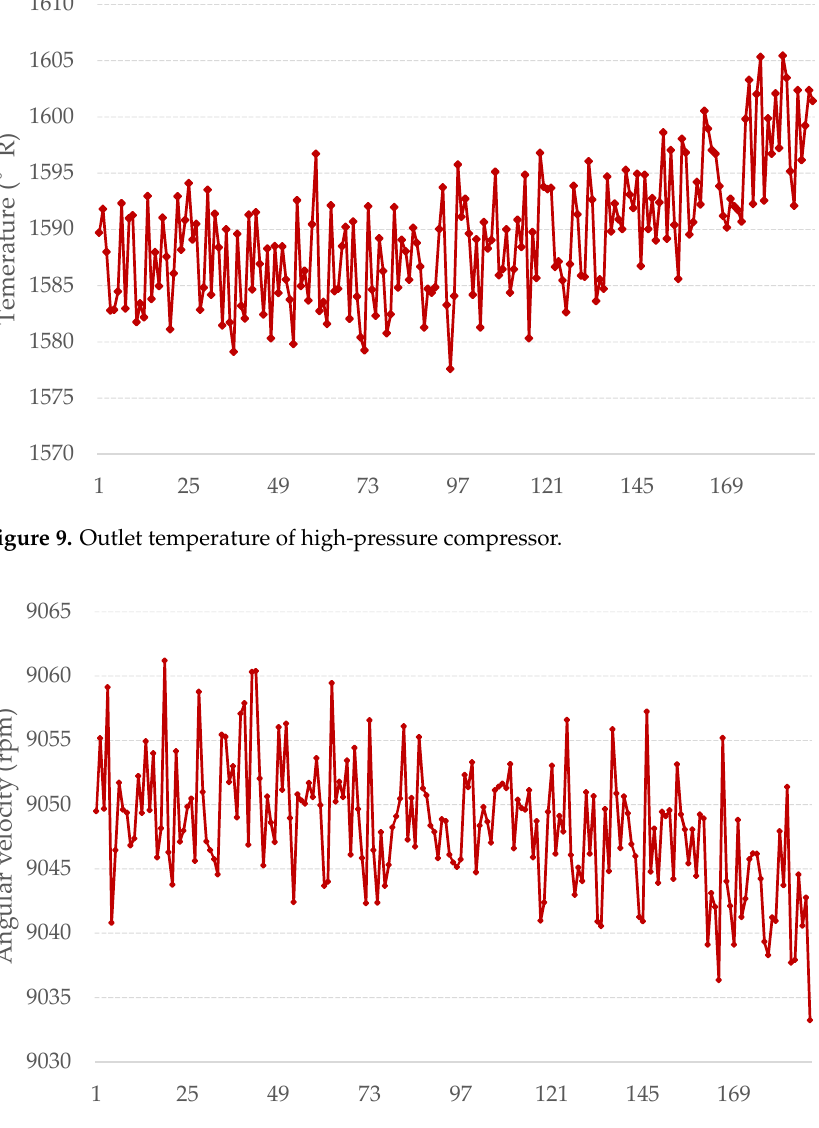
Figure 10. Actual angular velocity of core machine.